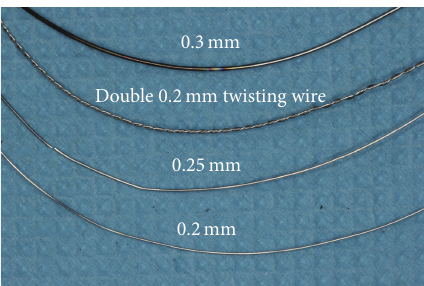
Figure 1: Selecting the stainless wire for tension around the contact area. 0.2, 0.25, or 0.3 mm stainless wire or double 0.2 mm twisting wire can be chosen according to the mesiodistal distance of the contact area. The double-twist 0.2 mm wire should be softened by heat treatment to reduce the